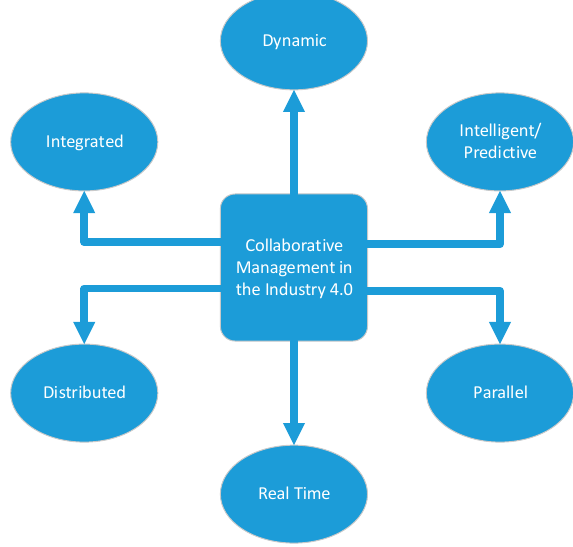
Figure 4. Proposed collaborative management framework.